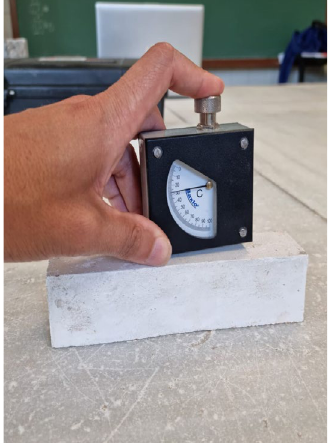
Figure 3. Shore C durometer test.